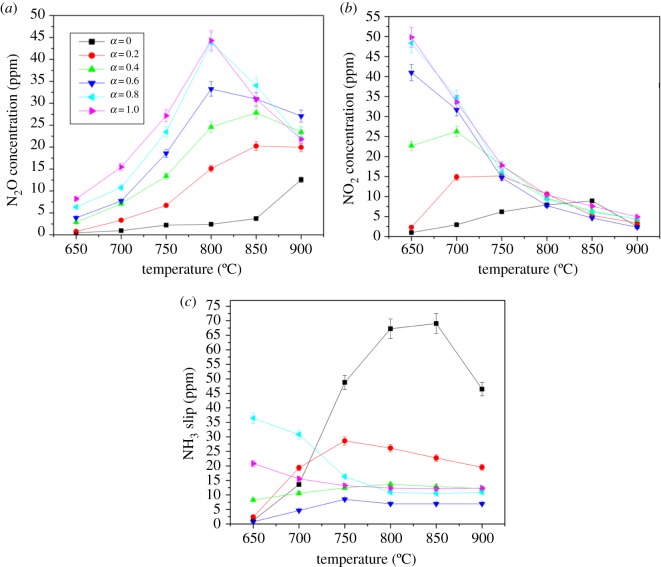
Effect of urea-C2H5OH on secondary pollutants.